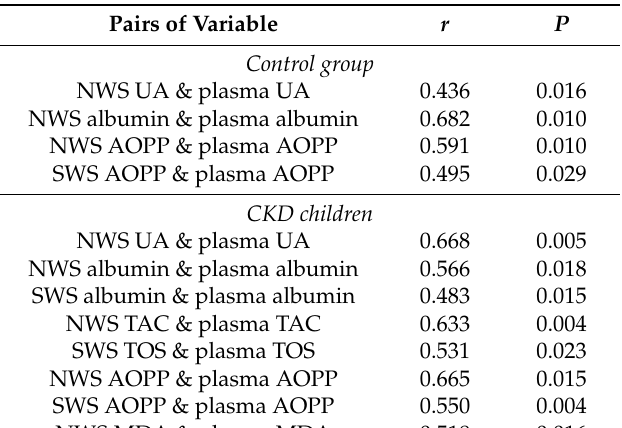
Table 6. Correlations between salivary and blood oxidative stress biomarkers in children with chronic kidney disease (CKD) and the controls.